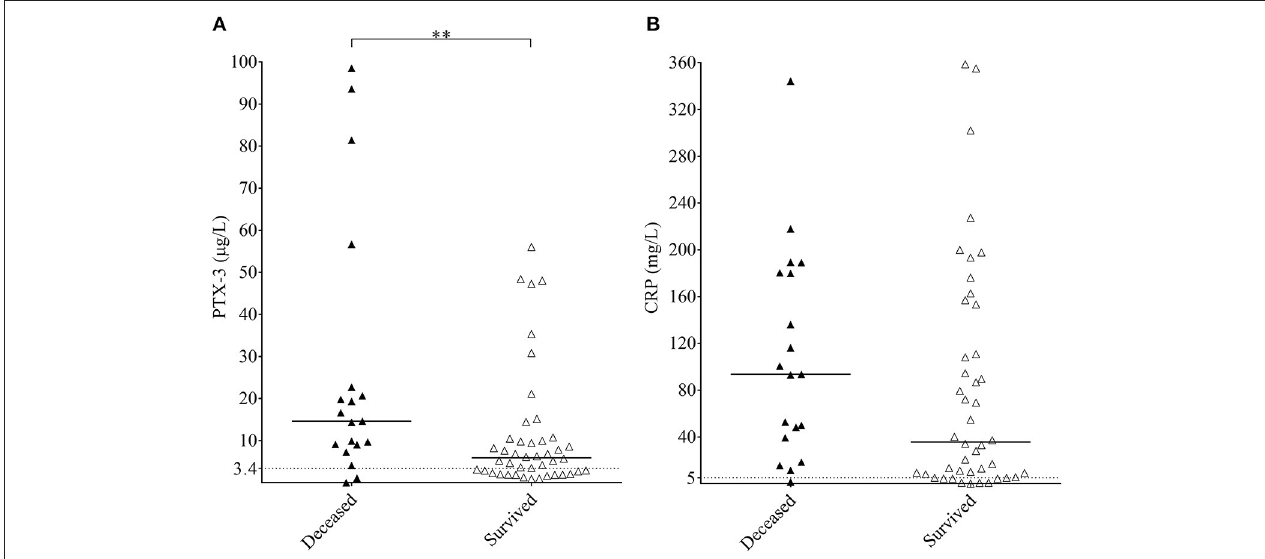
FIGURE 4 | Association of the systemic pentraxin levels to acute phase mortality in secondary TMA. PTX3 (A) and CRP (B) levels of acute phase secondary TMA patients are shown, grouped based on the 31-day survival of patients (deceased, black triangles; survived, white triangles). Data are expressed as mean of technical duplicates, the horizontal line indicates the median of each group, while an intermittent line shows the calculated cutoff of each pentraxin, respectively. Statistical analysis was performed with the Mann-Whitney test. Statistical significance is indicated by asterisks (** p < 0.01). CRP, C-reactive protein; PTX3, pentraxin-3; TMA, thrombotic